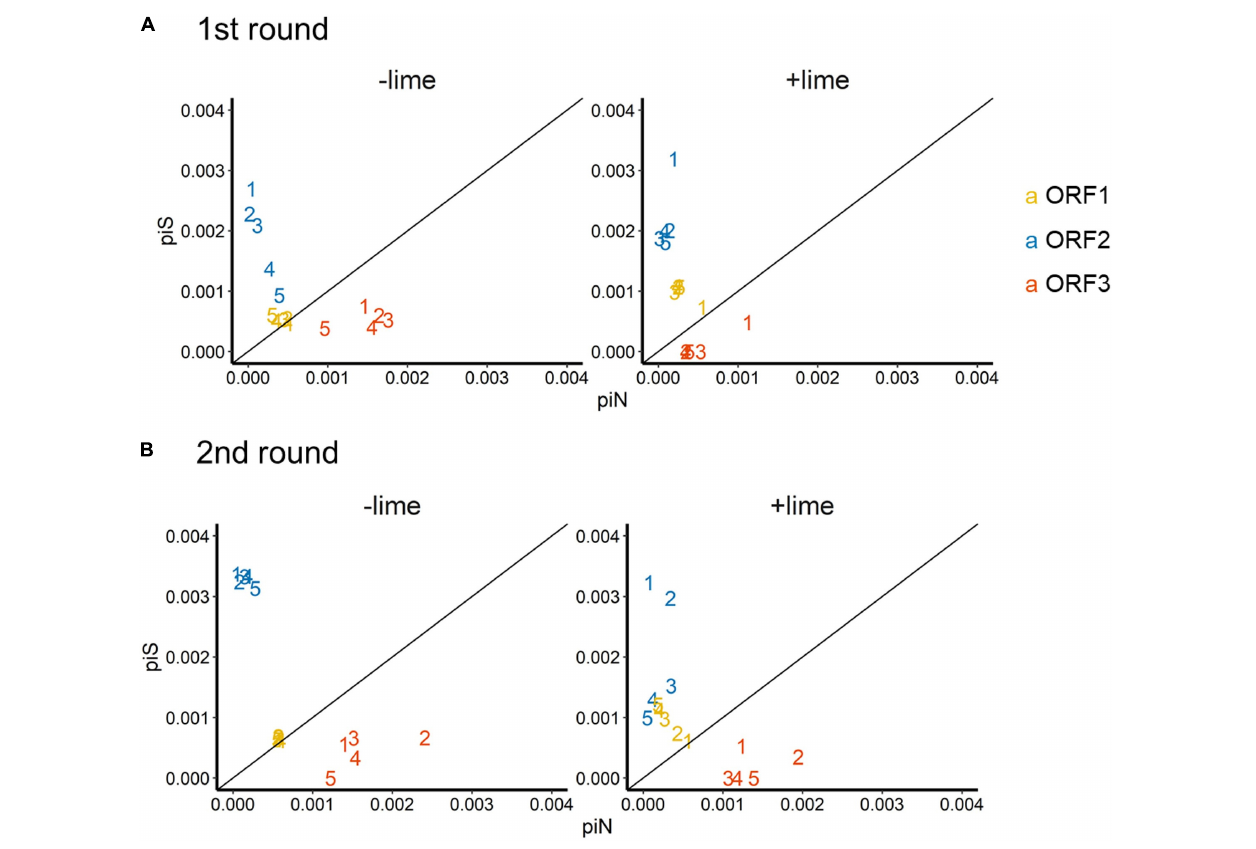
FIGURE 4 | Time series of nucleotide diversity at non-synonymous sites (piN) and synonymous sites (piS) in each protein coding gene [open reading frames (ORFs) 1, 2, and 3] in the first (A) and second (B) rounds. Each passage time is described as the number on panels. Solid lines represent the 1:1 relationship between piS and piN indicative of natural selection and neutral